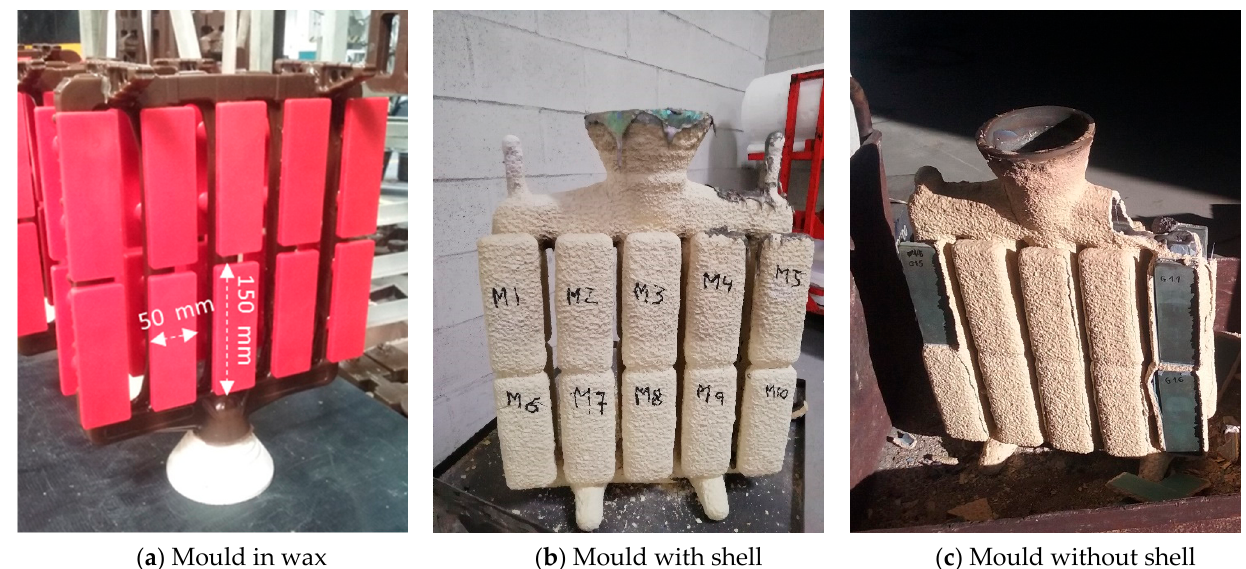
Figure 1. Investment casting moulds in different manufacturing steps. Table 1. Chemical composition of alloy 718 casting heats in weight percentage.